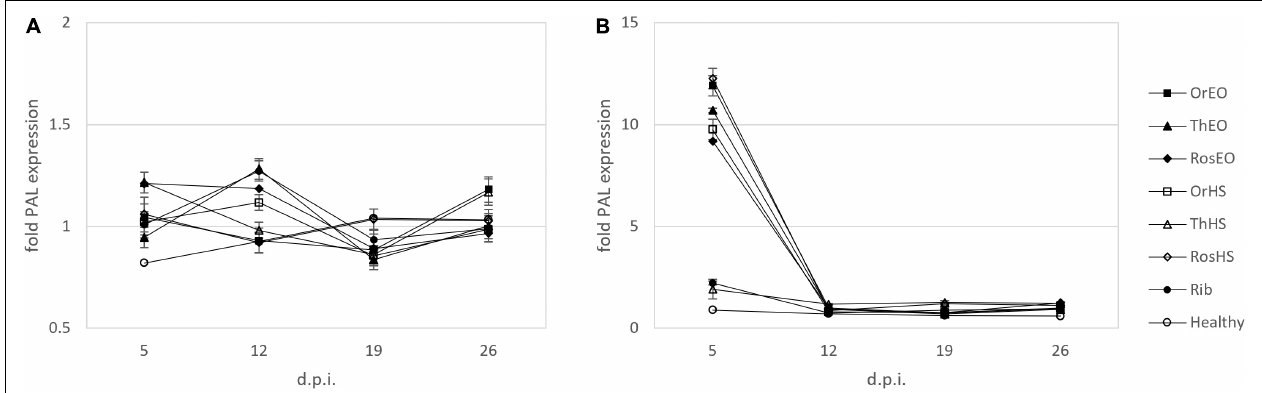
FIGURE 5 | Relative expression of PAL in plants treated together with inoculation (A) and treated after inoculation of ToLCNDV (B) on leaves harvested at 5, 12, 19, and 26 d.p.i. OV EO, O. vulgare essential oil; TV EO, T. vulgaris essential oil; RO EO, R. officinalis essential oil; OV HS, O. vulgare hydrosol; TV HS, T. vulgaris hydrosol; RO HS, R. officinalis hydrosol; Rib, ribavirin; Healthy, mock-inoculated plants. Columns represent mean value from 2 technical replicates on 3 pooled biological replicates and bars indicate standard error ( ±